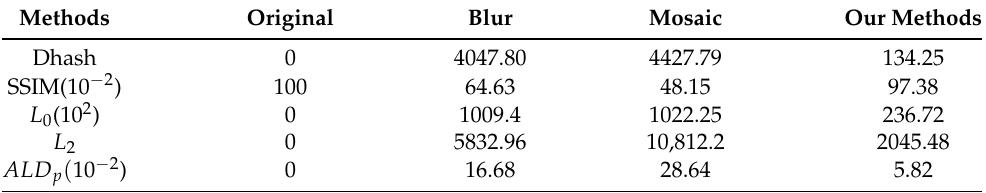
Table 2. Average result of 4000 facial images with the metrics: Dhash, SSIM, L 0 , L 2 , ALD p .